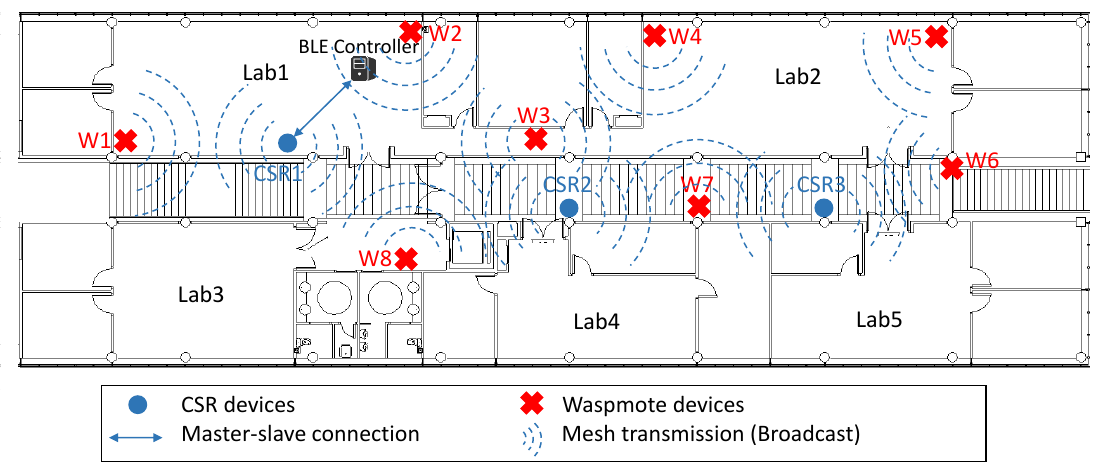
Figure 14. Network deployed using 8 sensor devices without master-slave